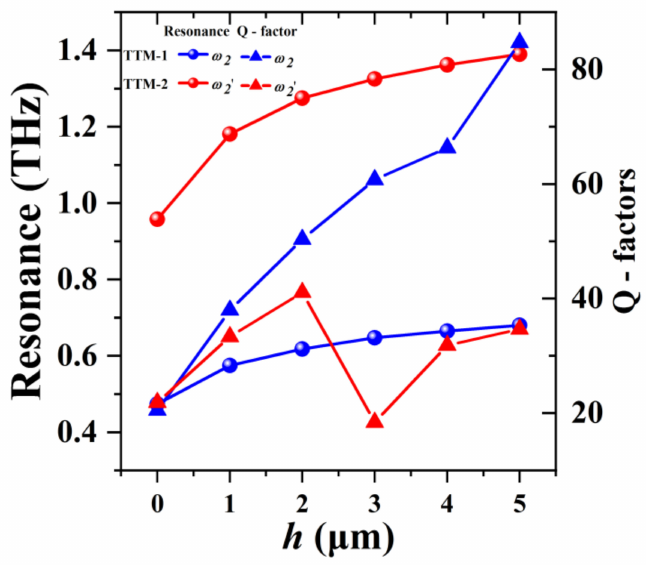
Figure 7. Relationships of resonances and Q-factors with different h values of TTM-1 and TTM-2. To further investigate the practical applications of TTM devices, TTM-1 and TTM-2 are exposed on the surrounding ambient with different refraction index ( n ). Figure 8a,b show the transmission spectra of TTM-1 and TTM-2 with h = 4 µ m (orange line) and h = 0 µ m (blue line) exposed on different n values, respectively. The second resonance is generated from the inner SRR and red-shifted by increasing n value from 1.0 to 1.5. The first and third resonances are shifted slightly. The resonance shifts of TTM-1 and TTM-2 with h = 4 µ m are larger than those with h = 0 µ m as the orange and blue areas shown in Figure 8. It means that TTM devices are more sensitive to the change of ambient n value at the condition of h = 4 µ m. In Figure 8b, the EIT resonance generated by the resonance of inner SRR shifts from 1.365 THz to 1.253 THz when n changes from 1.0 to 1.1. The relationships